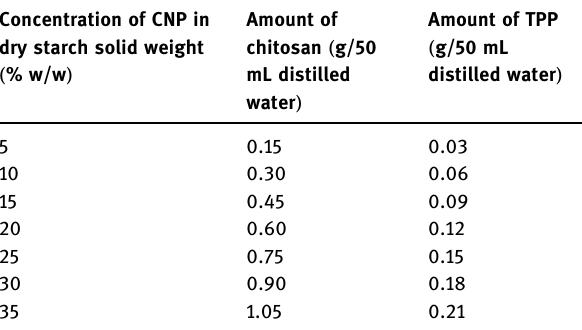
Table 1: The concentration of CNP in dry starch solid weight and the respective amount of chitosan and TPP based on chitosan to TPP ratio of